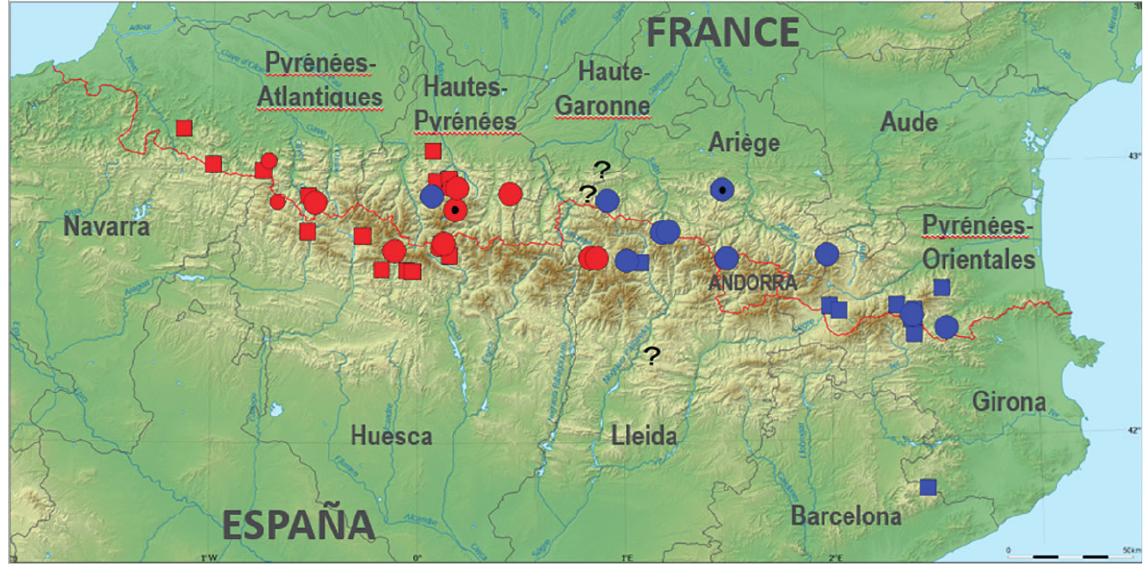
Fig. 21. Map of the Pyrenean region with the distribution of Dicranopalpus pyrenaeus Dresco, 1948 (red symbols) and Dicranopalpus catariegensis sp. nov. (blue symbols). Dots, studied samples; squares, literature records. Type localities are indicated by a black spot. The two French sites indicated by ‘?’ were recorded by Dresco (1948) as D. pyrenaeus ; the Spanish ‘?’ was recorded by Bellés (1978) as Dicranopalpus sp. (